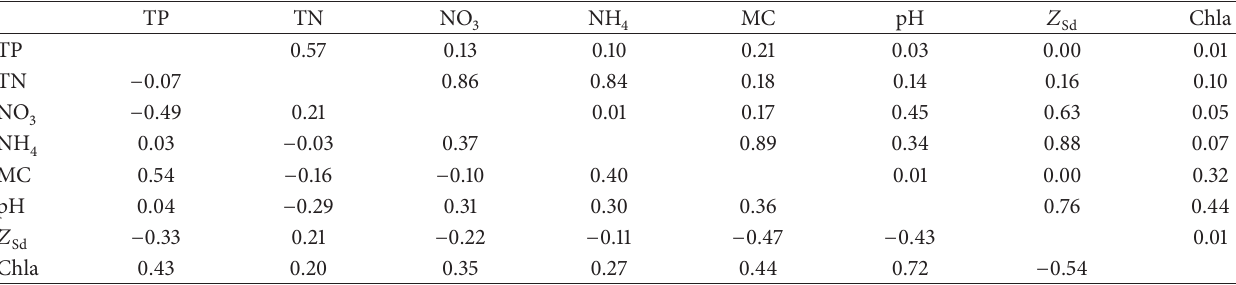
Table 3: Pearson (upper-right corner) and Spearman’s rank (lower-left corner) correlation coefficients ( r ) between variables. TP: